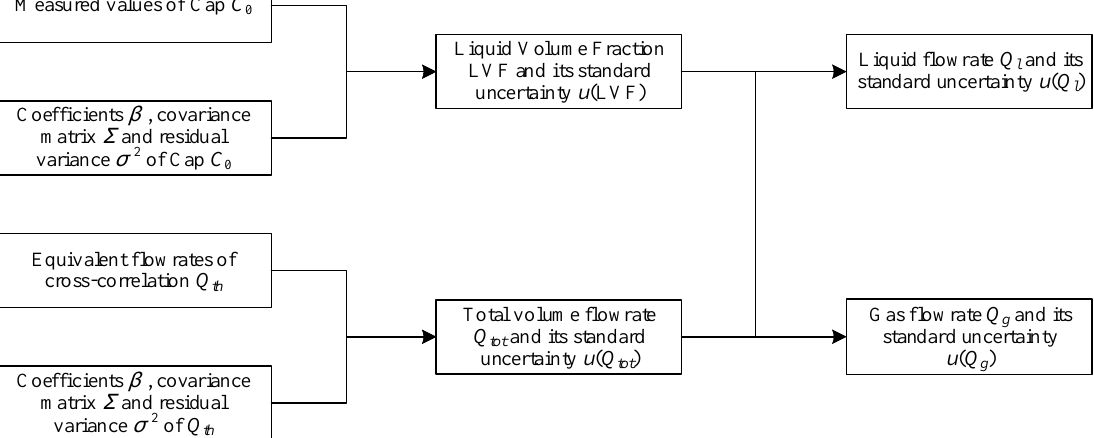
Figure 4. The calculation procedures of the capacitance and cross-correlation (Cap + CC) method.